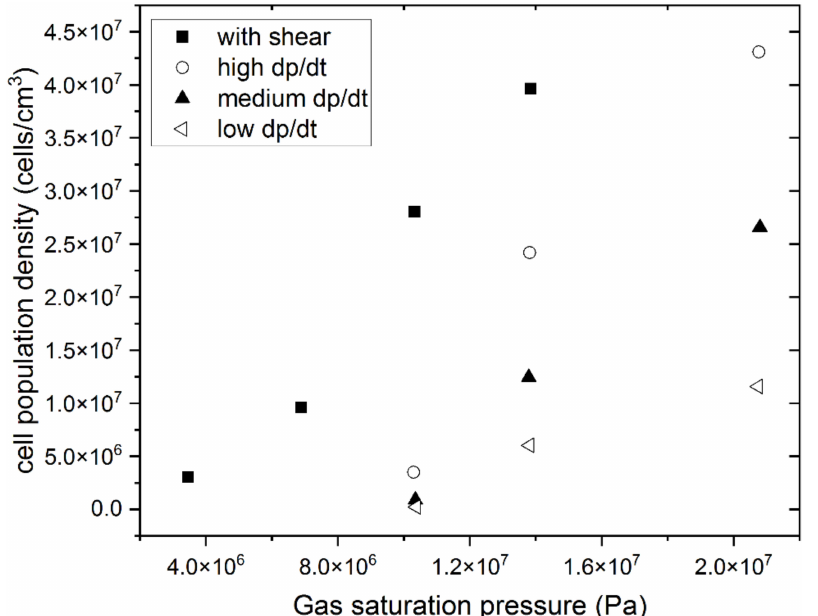
Figure 11. Cell population density as a function of gas saturation for HDPE foamed with different pressure drop rates and the application of shear